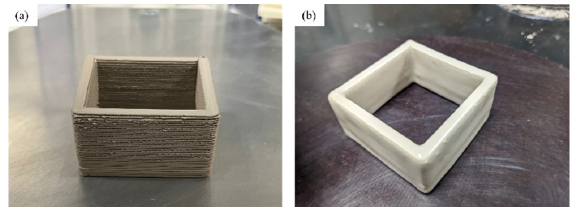
Figure 1. Cone 5 porcelain print through DIW: non-fired ( a ) and fired ( b )